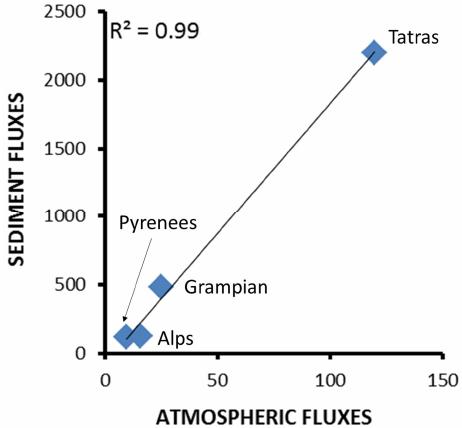
Figure 4. Average PAH sediment and atmospheric deposition fluxes at the high-altitude lakes considered in this study. Units in µgm − 2 yr − 1